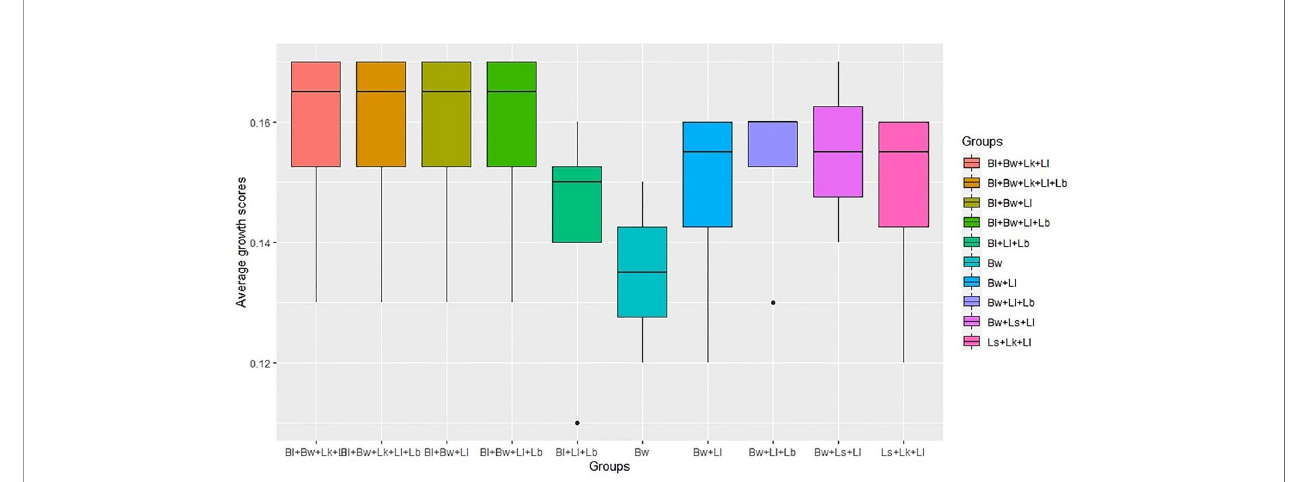
FIGURE 4 | Top 10 community model groups with highest average growth scores (Bw, B. weihaiensis ; Ll, L. lindneri ; Bl, B. licheniformis ; Ls, L. sakei ; Lk, L. Koumiss ; Lb, L. buchneri